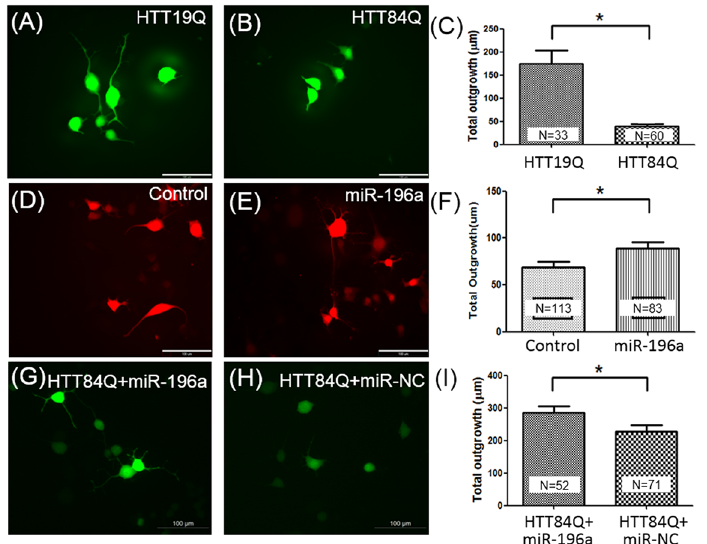
Fig 4. The effects of miR-196a on neurite outgrowth in N2a mouse neuroblastoma cells. N2a cell were transfected with different constructs, including HTT19Q (A), HTT84Q (B), miR-non relative control (NC; D), miR-196a (E), HTT84Q+miR-196a (G) or HTT84Q+miR-NC (H), and neurite outgrowth was analyzed though the Neurite Outgrowth Application Module of the MetaMorph software. Fluorescent images(A, B, D, E, G and H) show the morphology of neurite outgrowth in different groups as indicated, and statistically quantitated data between HTT19Q and HTT84Q (C), Control and miR-196a (F) and HTT84Q + miR-196a and HTT84Q + miR-NC (I) are